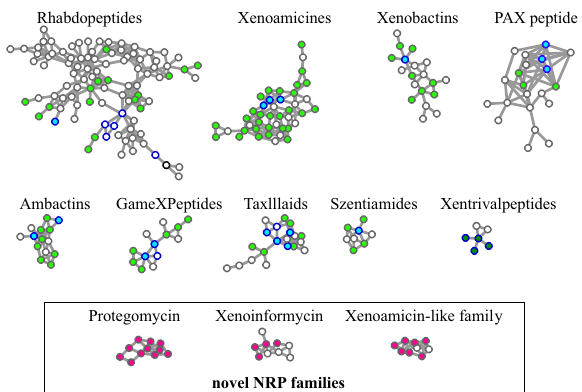
Fig. 2 Spectral networks for nine known and three previously unreported NRP families identi fi ed by NRPminer in the XPF dataset. Each node represents a spectrum. The spectra of known NRPs (as identi fi ed by spectral library search against the library of all known compounds in GNPS) are shown with a dark blue border. A node is colored if the corresponding spectrum forms a statistically signi fi cant PSM and not colored otherwise. We distinguish between identi fi ed spectra of known NRPs with known BGCs 31 (colored by light blue) and identi fi ed spectra of known NRPs (from xentrivalpeptide family) with previously unknown BGC (colored by dark green). Identi fi ed spectra of previously unreported NRPs from known NRP families (previously unreported NRP variants) are colored in light green.